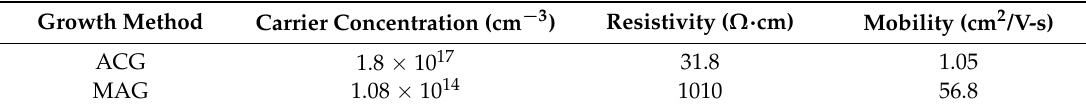
Table 1. Electrical and conductive properties of samples grown with ACG and MAG methods. Growth Method